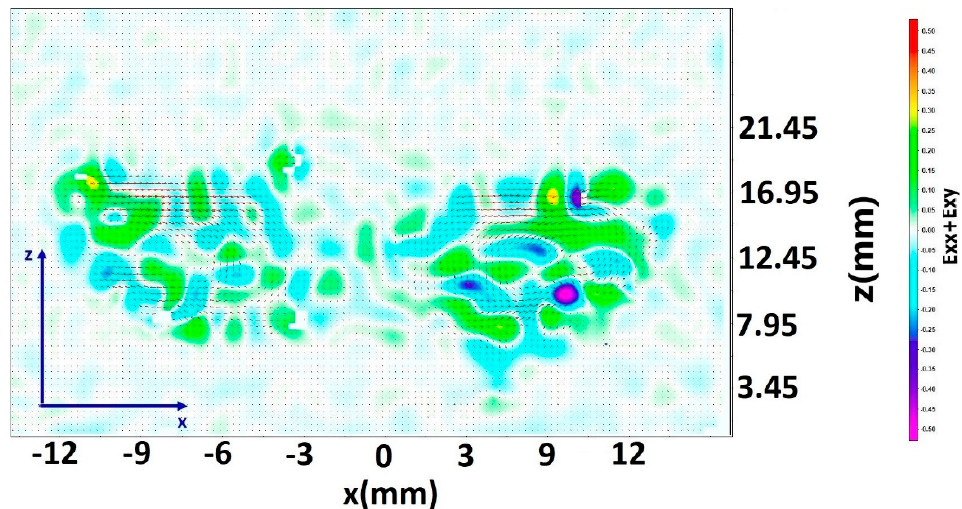
Figure 4. Divergence of the vector field in the dusty crystal.